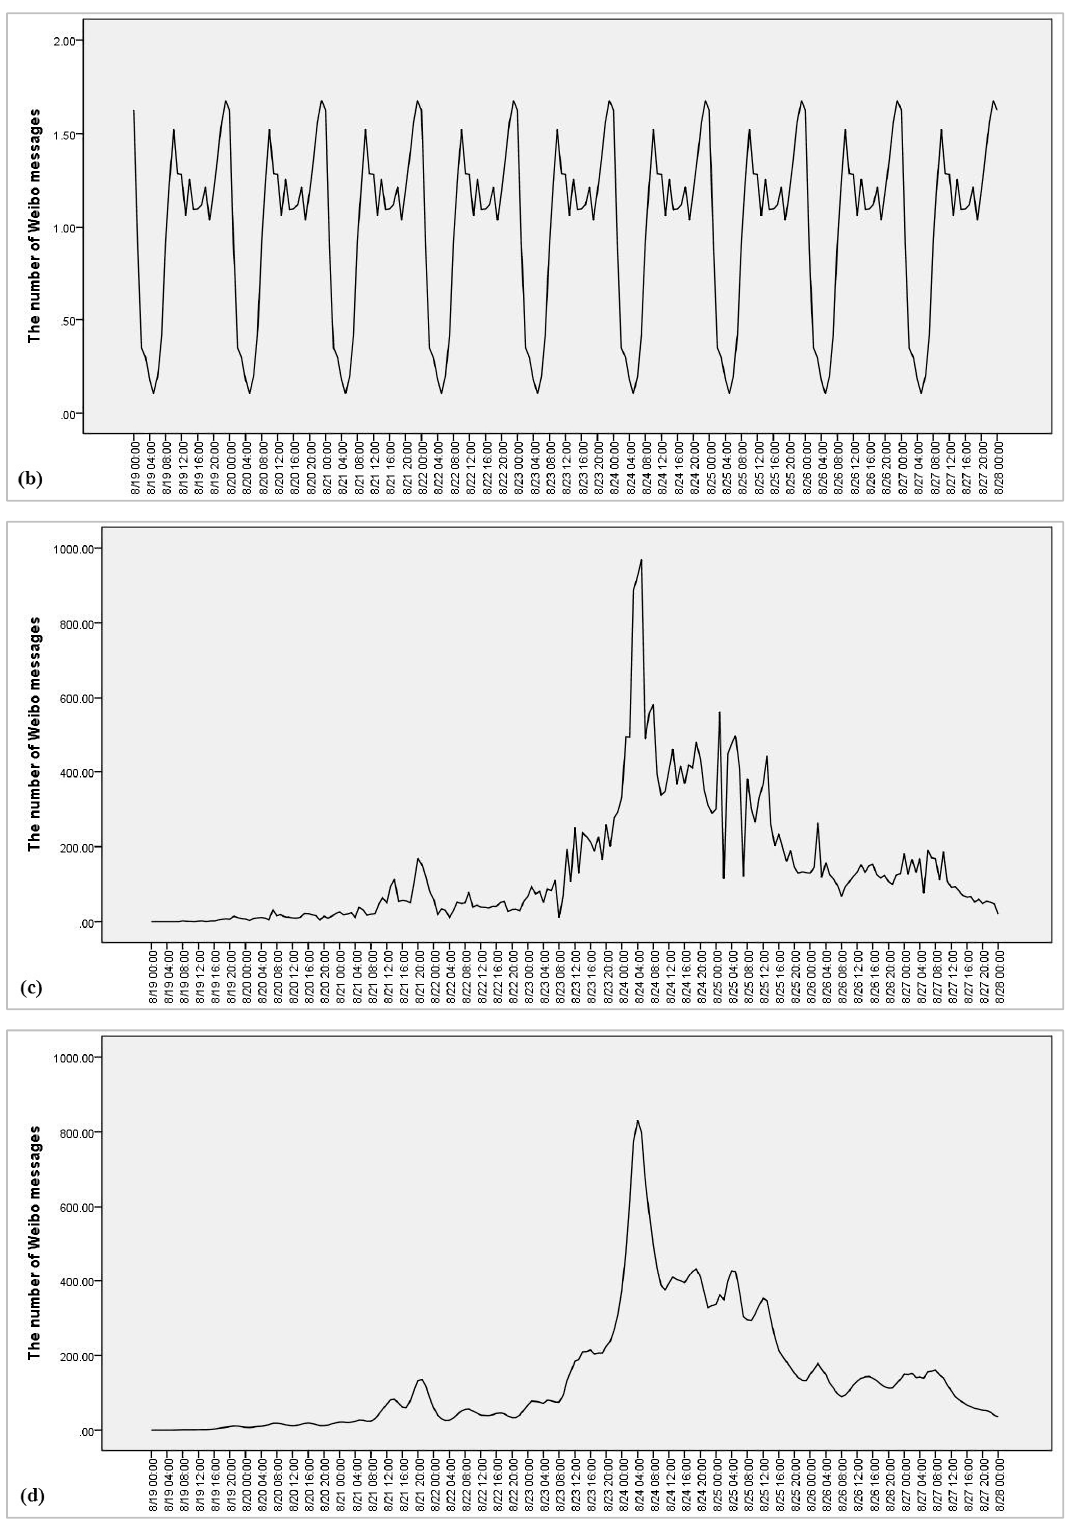
Figure 3. The seasonal-trend decomposition of the temporal trends of flood-related Weibo. ( a ) Original temporal trend of the Shouguang flood; ( b ) seasonal component; ( c ) the seasonally adjusted time series; ( d ) trend component.